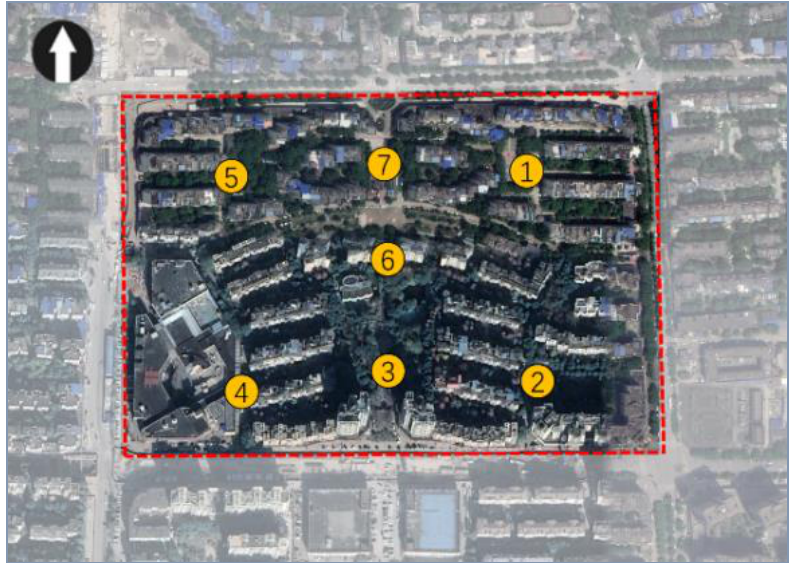
Figure 5. The location of the measurement points.